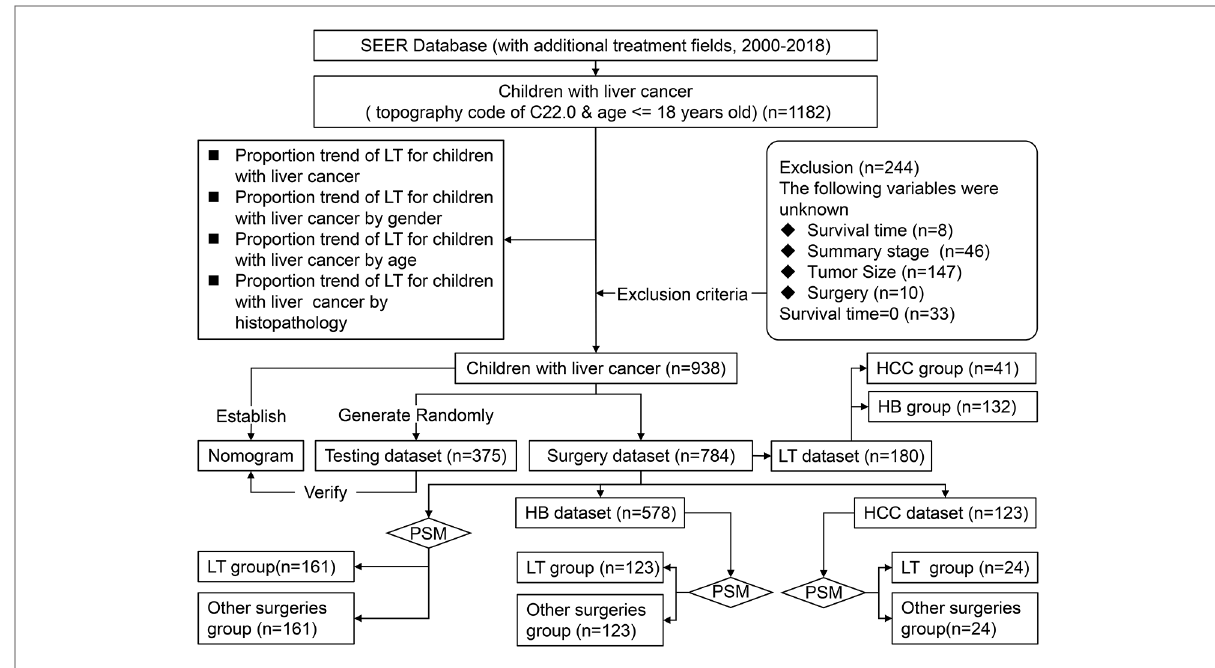
FIGURE 1 Flowchart of screening children with liver cancer in the SEER